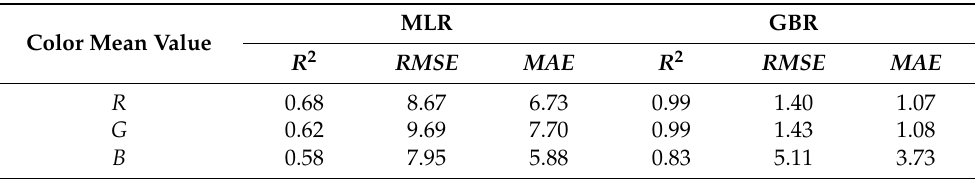
Table 2. Performance training metrics of multiple linear regression (MLR) and gradient boosting regression (GBR)